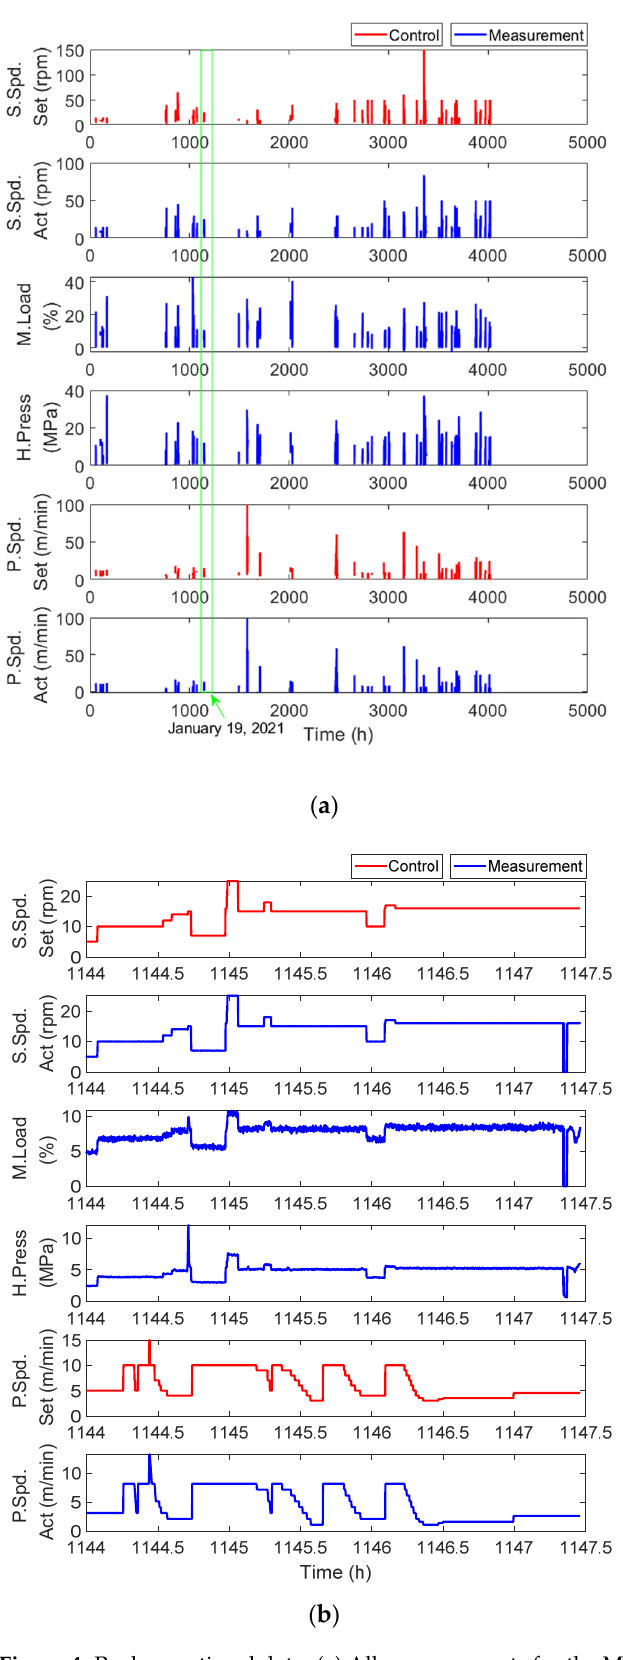
Figure 4. Real operational data: ( a ) All measurements for the Maddock screw; ( b ) Extrusion data for the Maddock screw collected on 19 January 2021.